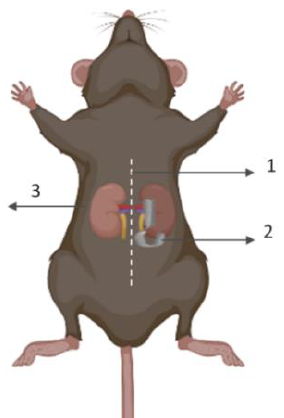
Figure 1. Mouse model of I/R-induced AKI. (1) Laparotomy, followed by (2) 30 min of right renal ischemia, in parallel to (3) left nephrectomy (control sham). Forty-eight hours after reperfusion, blood and kidneys are harvested for the assessment of the ischemic damage. (Created with BioRen- der.com).